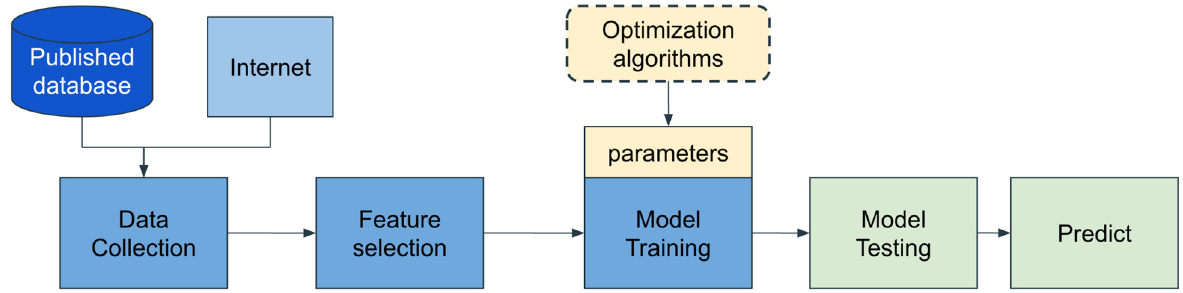
Figure 2. Machine learning flowchart for detecting phishing websites.